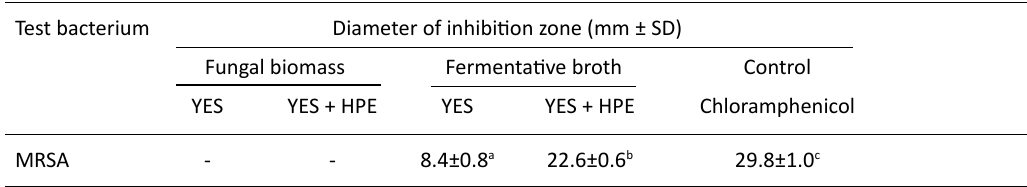
Table 1. Anti-MRSA activity of fungal extracts on disc diffusion assay Test